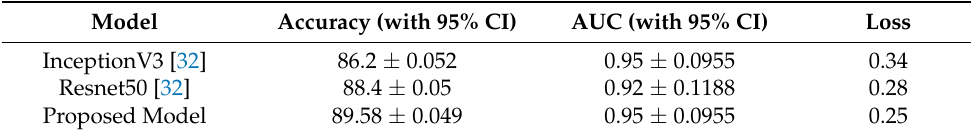
Table 1. Performance of various models for forecasting Normal/Abnormal.